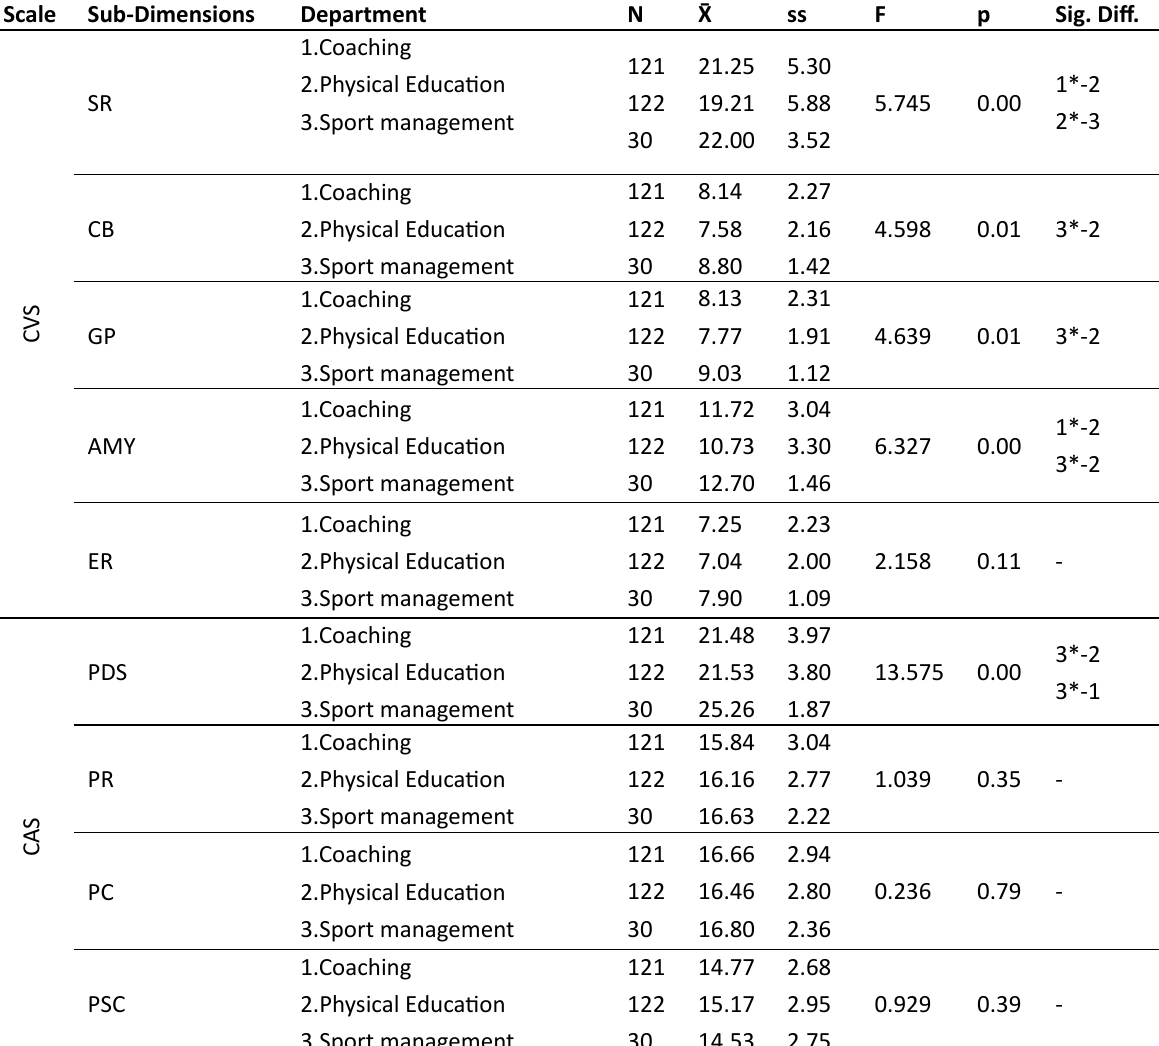
Table 5. Anova-Test results of participants’ CVS and CAS sub-dimensions in terms of the variables of department Scale